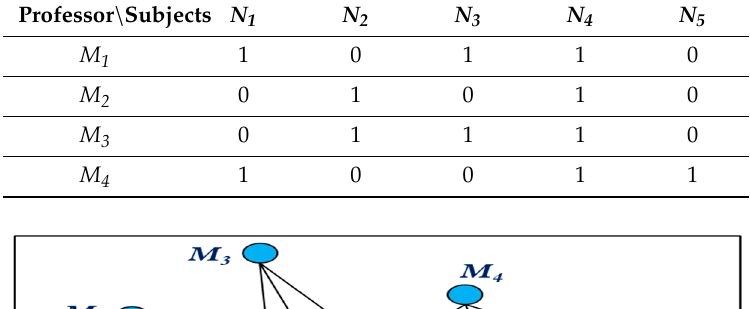
Table 2. Teaching with four professors and five subjects.